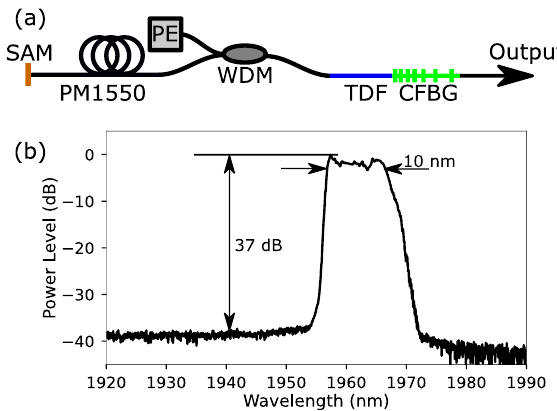
Figure 1. Experimental setup of the linear cavity (a) and output spectrum